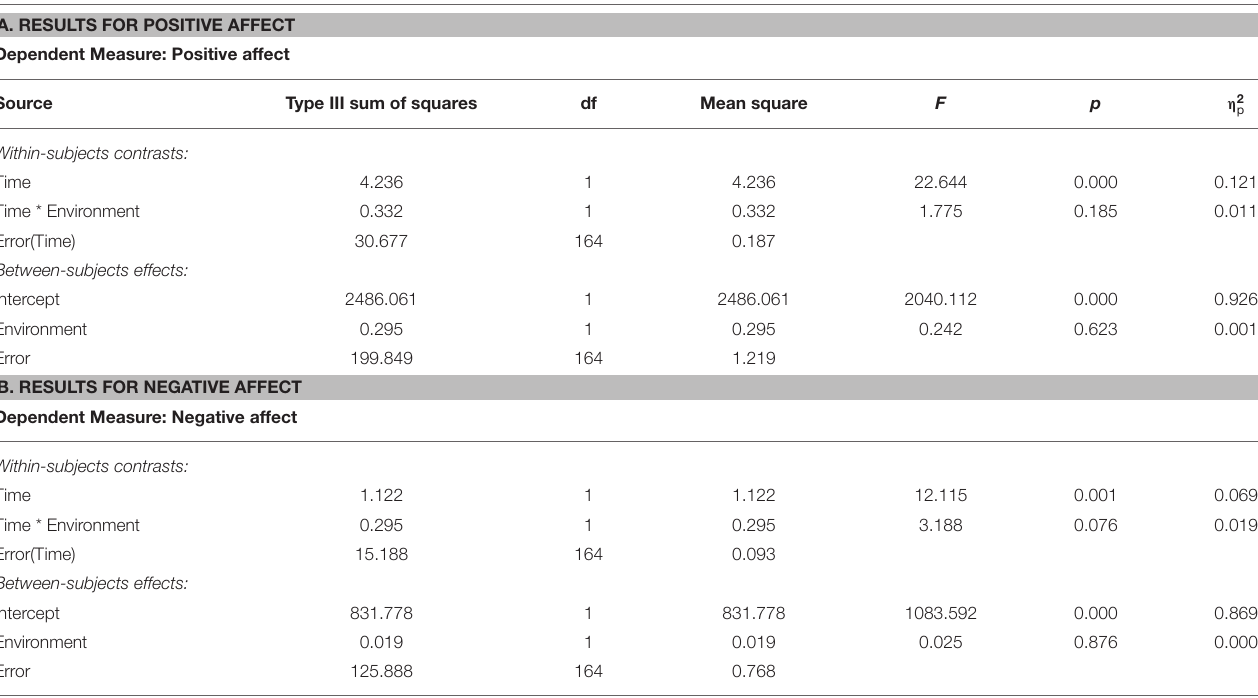
TABLE 10 | Results from ANOVAs on time (pre, post) × environment (nature, urban) effects on Positive vs. Negative Affect, for study samples with environment as a between-subjects